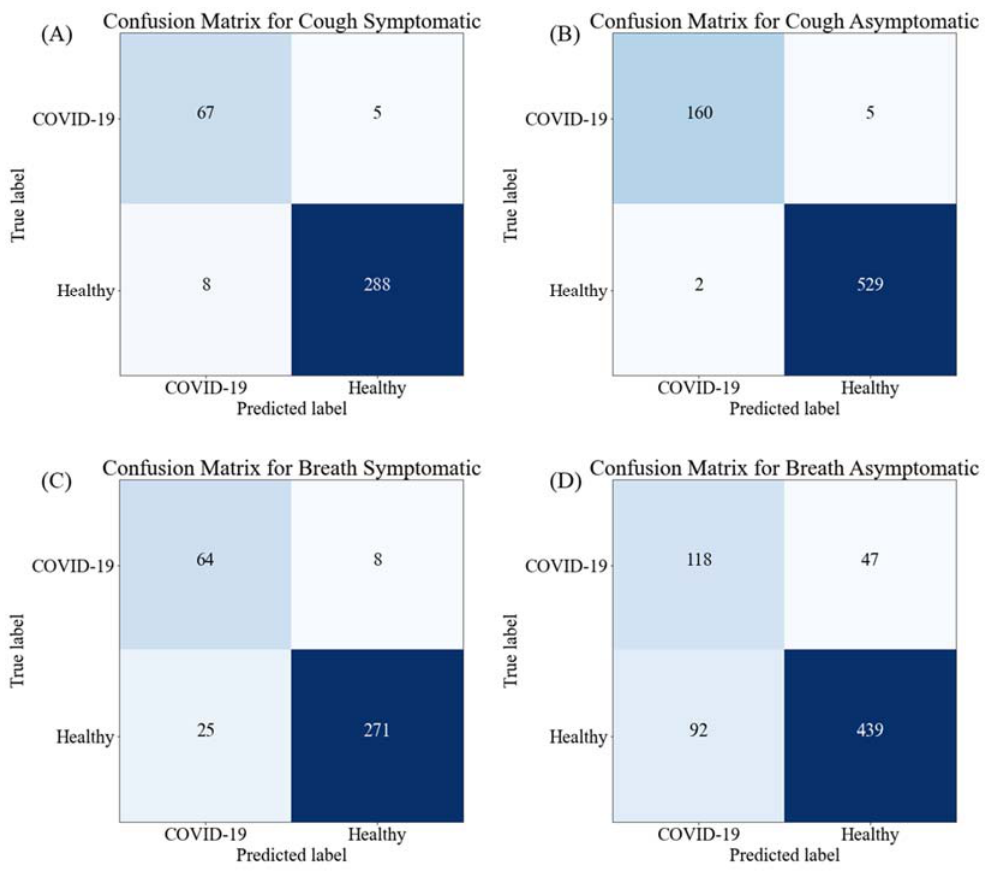
Figure 5. Confusion matrices for healthy and COVID-19 classification using cough sounds for ( A ) symptomatic patients and ( B ) asymptomatic patients, and using breath sounds for ( C ) symptomatic patients and ( D ) asymptomatic patients using best performing stacking CNN models.